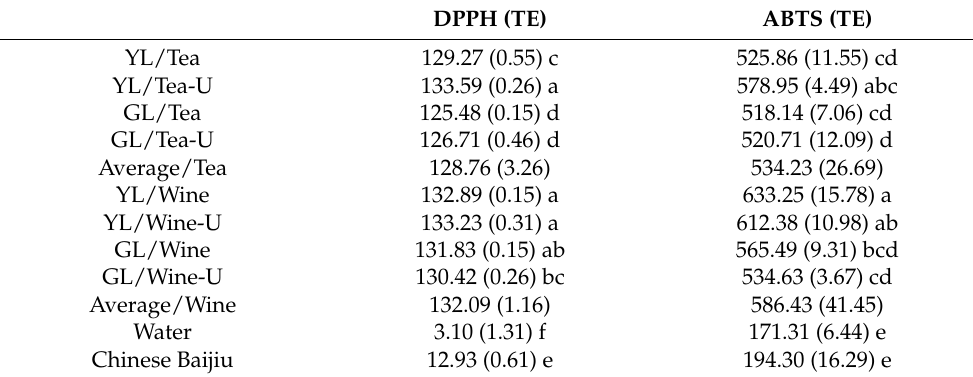
Table 1. Antioxidant properties of GBE